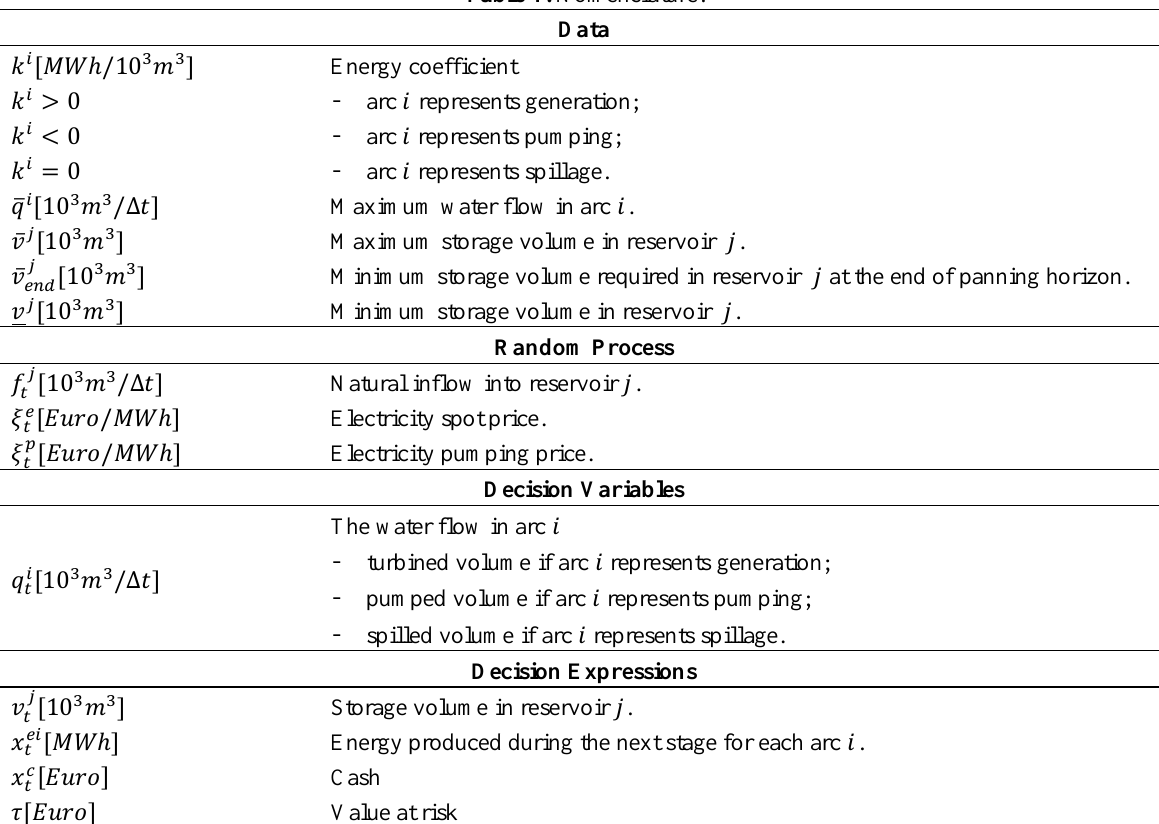
Fig. 9. Indifference prices for different contract sizes. Table 1.